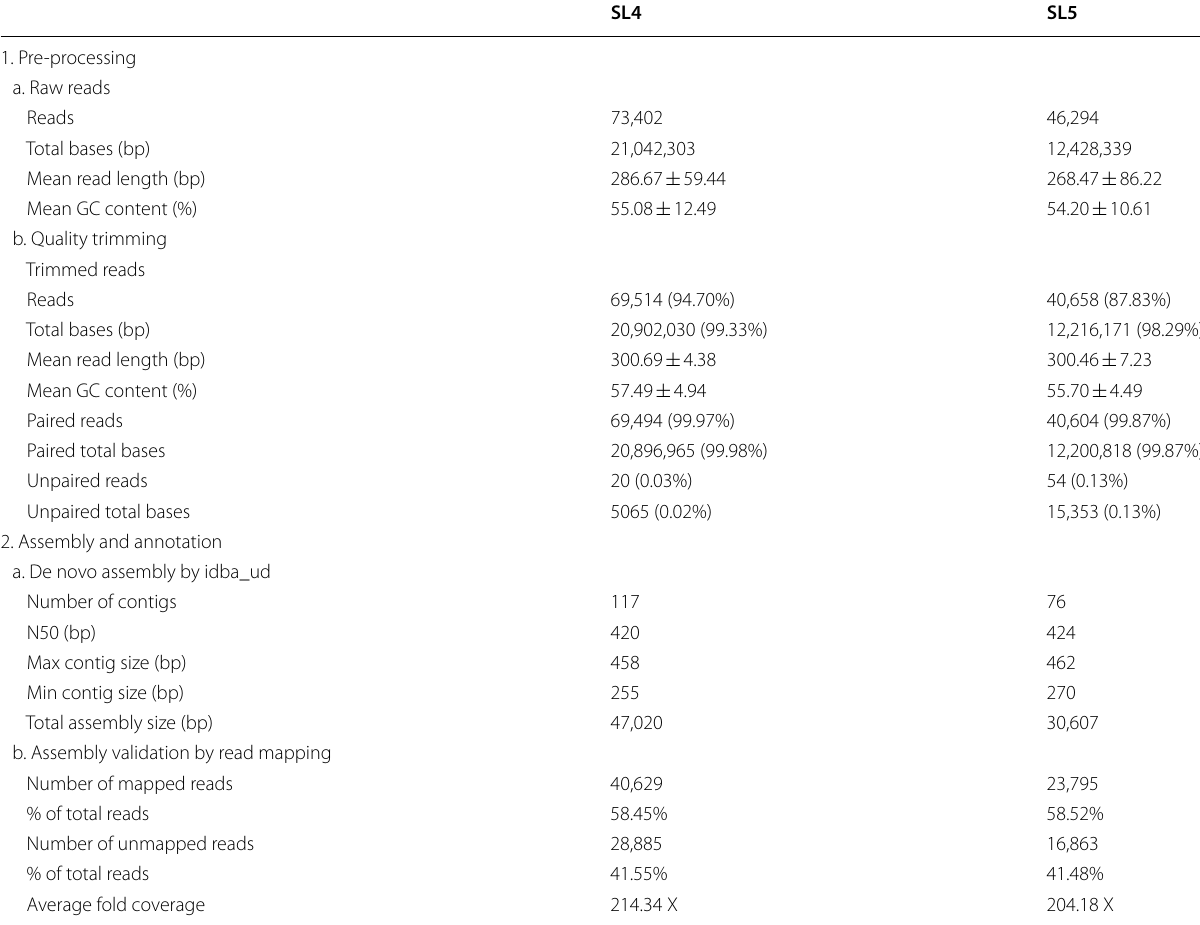
Table 2 General characteristics of SL4 and SL5 metagenomes